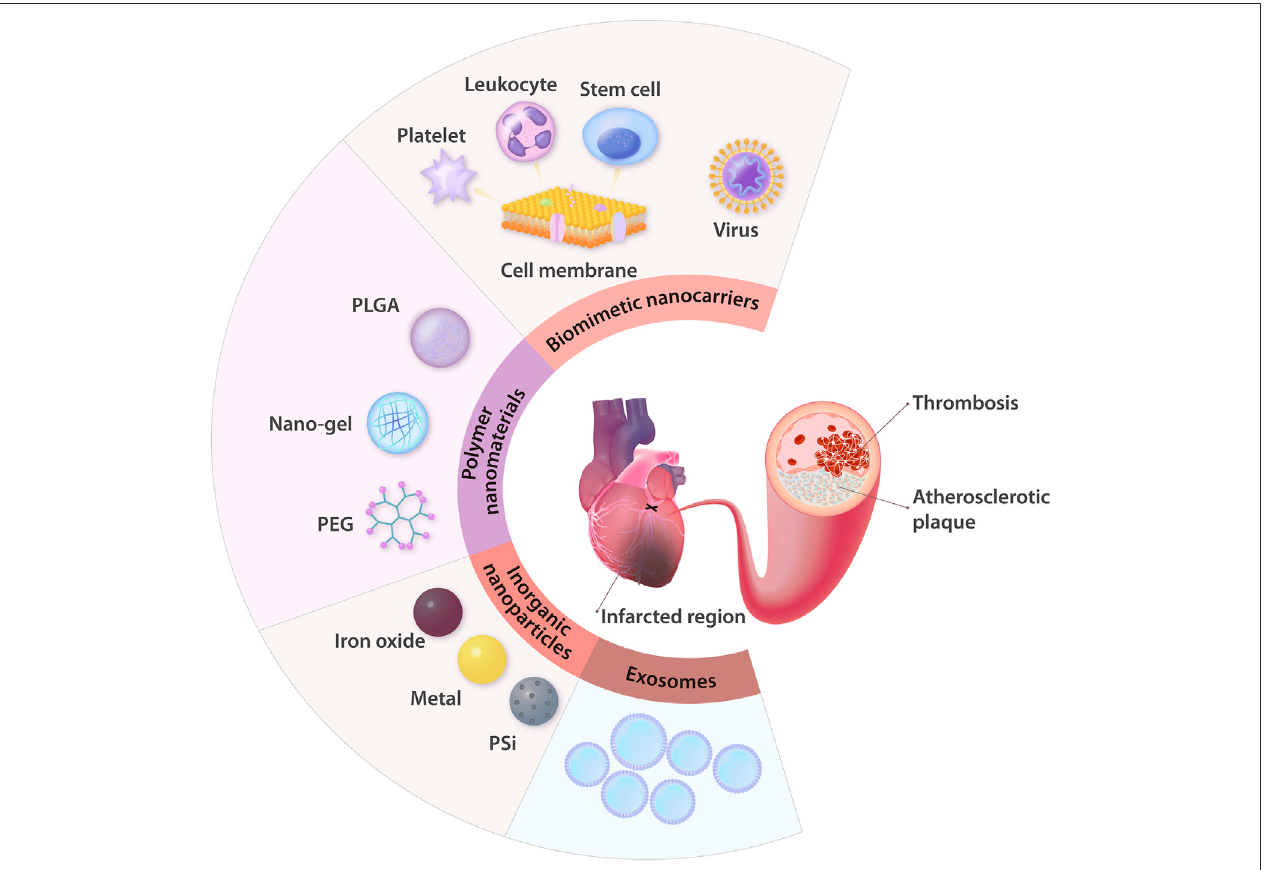
FIGURE 2 | Summary of the common NMs for drug delivery applied in ASCVD treatment. In the therapeutic fi eld of ASCVD, nanodelivery systems are mainly used to treat AS, thrombosis, and ischemic heart injury. The NMs most commonly applied in these systems are polymer NMs (e.g., PLGA, nano-gel, and PEG) and inorganic NPs (e.g.,iron oxide NPs,othermetalNPs,and PSiNPs). With the advantages ofnatural biological properties,exosomes,and cell membranes coated in NPscanserve asbiomimeticnanocarriers,andthisapproachisincreasinglybeingrecognizedasabrilliantstrategytotreatASCVD.PLGA:poly(D,L-lactic-co-glycolicacid);PEG: polyethylene glycol; PSi: porous